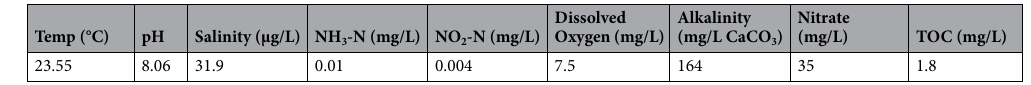
Table 1. Marine water initial